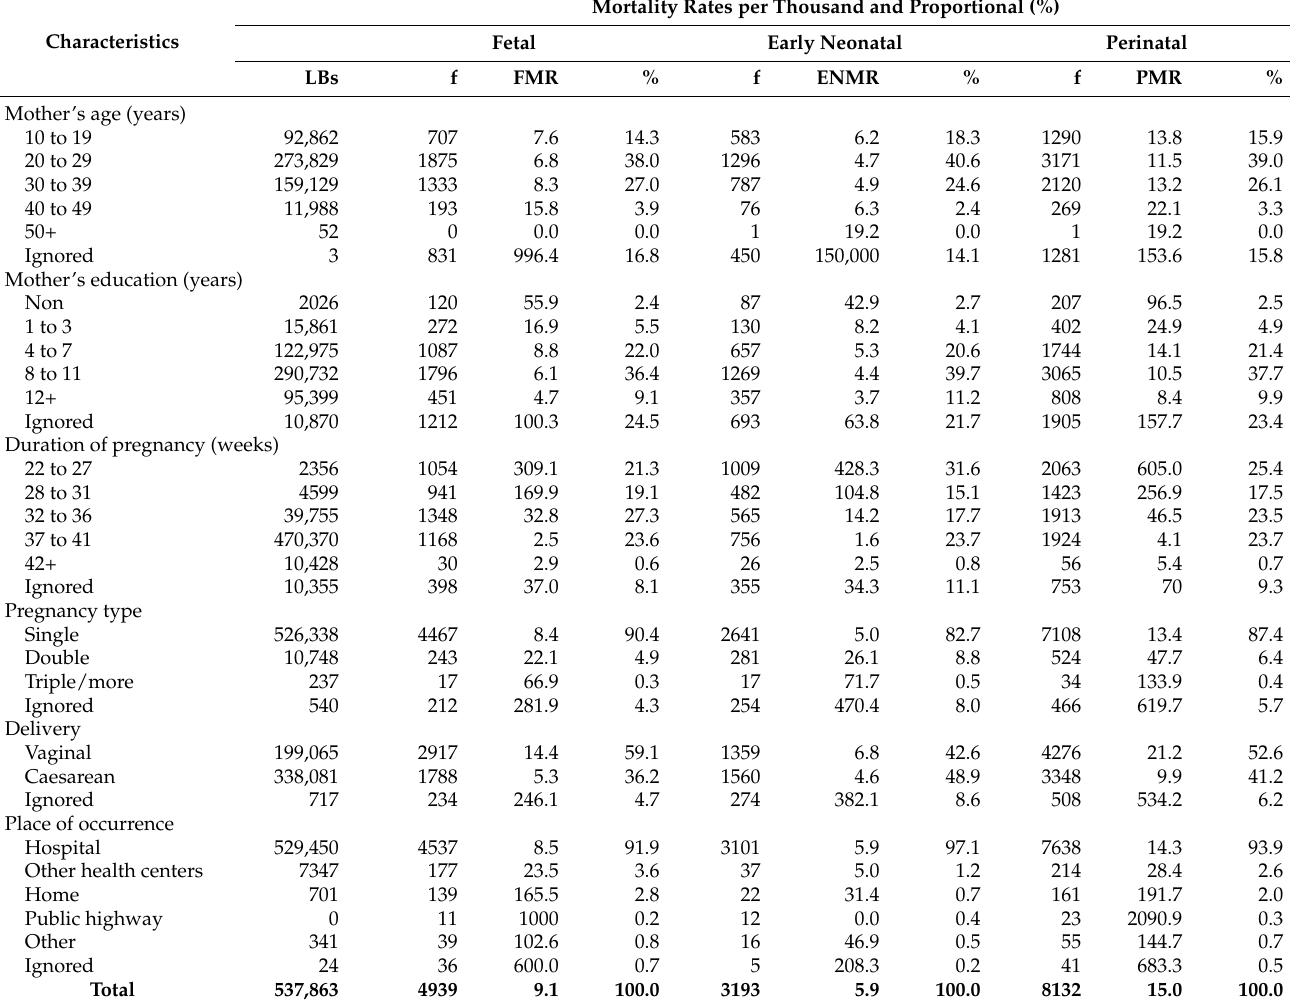
Table 2. Perinatal, fetal, and early neonatal mortality by maternal characteristics, pregnancy, childbirth, and place of occurrence. Esp í rito Santo, Brazil, 2008–2017.